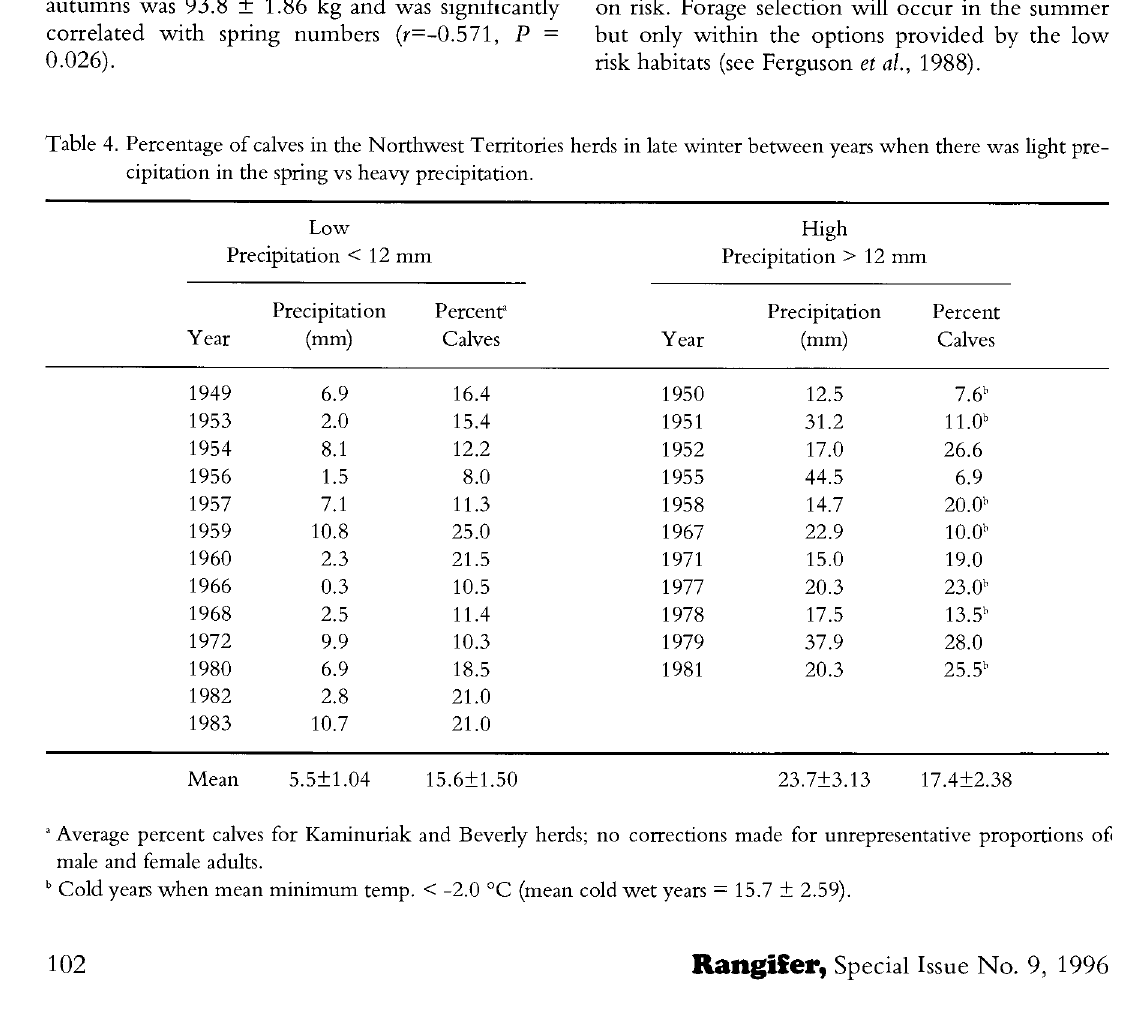
Table 4. Percentage of calves in the Northwest Territories herds in late winter between years when there was light pre cipitation in the spring vs heavy